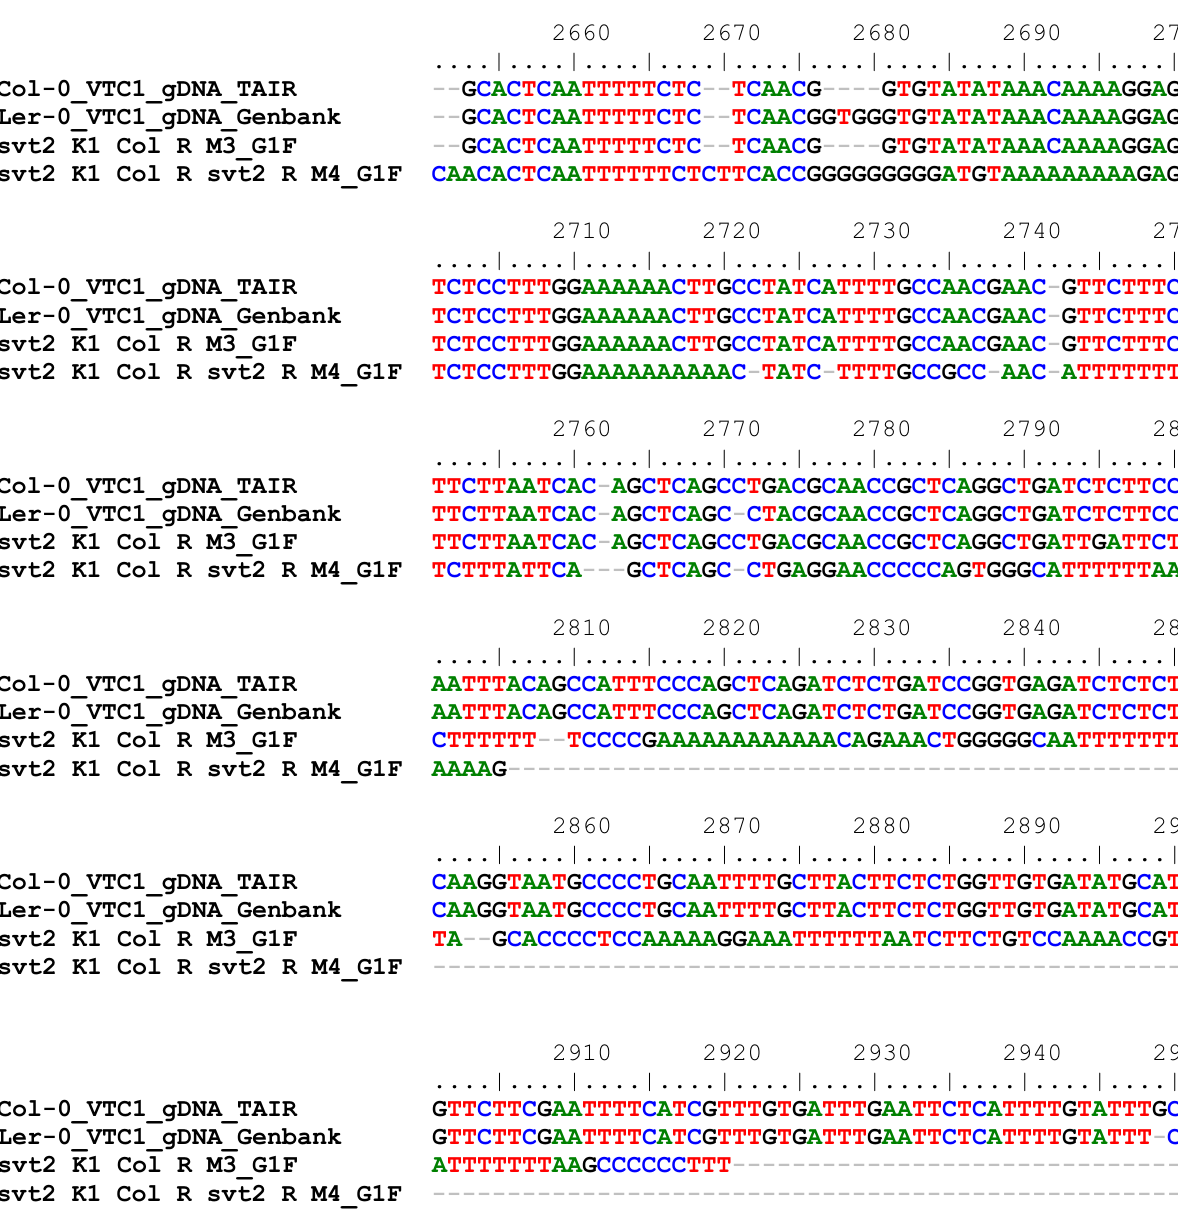
Figure S2. Sequence alignment of the VTC1 promoter InDel polymorphism sequence of the Col-0 TAIR database, the L er -0 Genbank database, the svt2 K1 Col R M revertant (Col-like phenotype) and the svt2 K1 Col R svt2 R M revertant ( svt2 -like phenotype). 3 4 Horizontal arrows denote 5´ respectively 3´ flanking regions of the sequence insertion, which is highlighted in grey, in the VTC1 promoter region in Ler-0 and svt2 K1 Col R svt2 R M4, which exhibits an svt2-like phenotype. The svt2 K1 Col R M3 mutant has a Col-like phenotype and share sequence similarities with the Col-0 sequence. R denotes